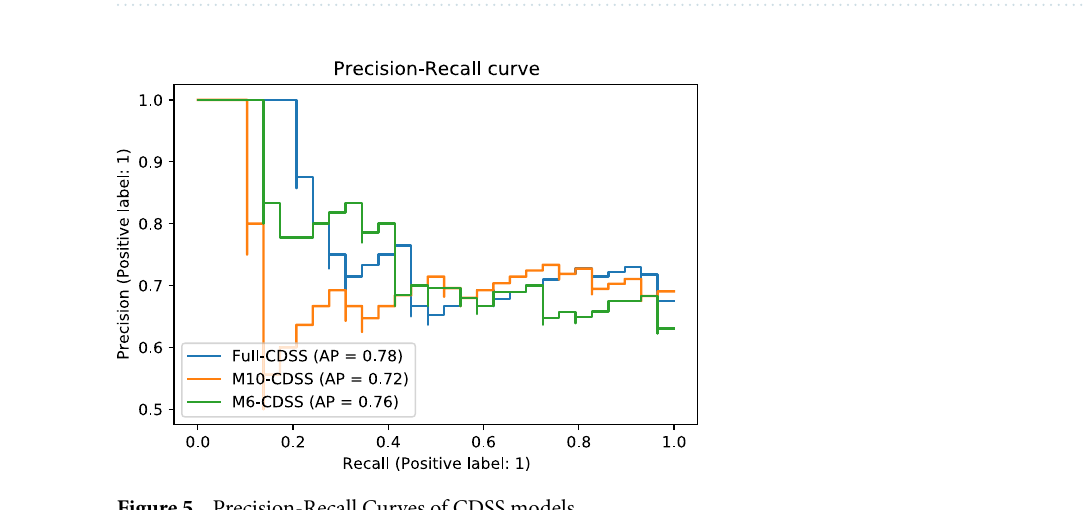
Figure 5. Precision-Recall Curves of CDSS